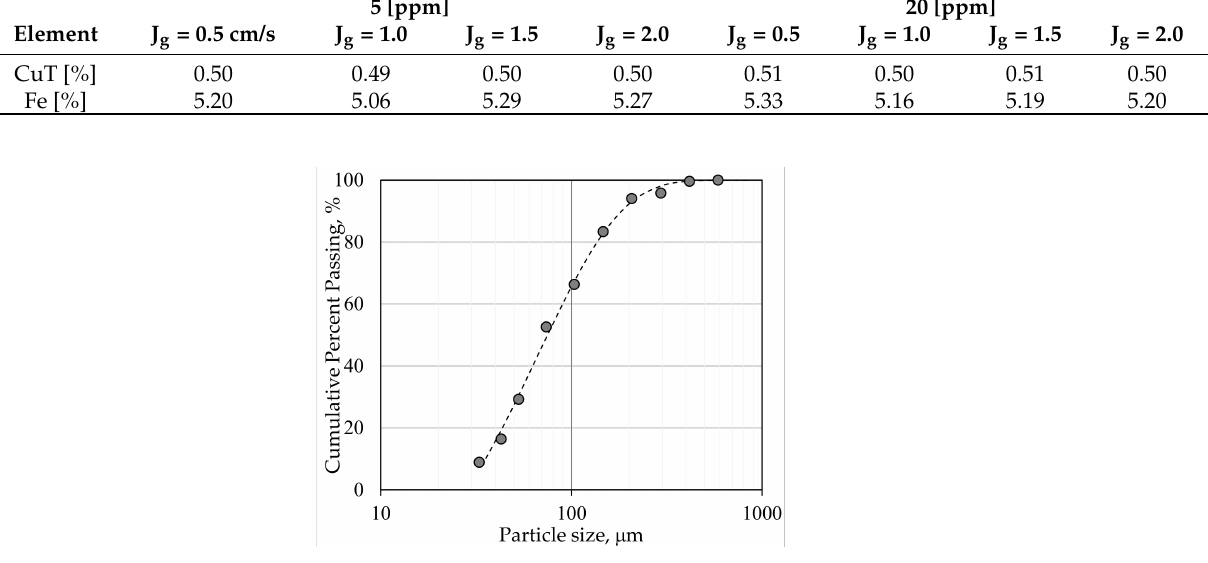
Figure 3. Particle size distribution of the mineral used in the flotation tests.